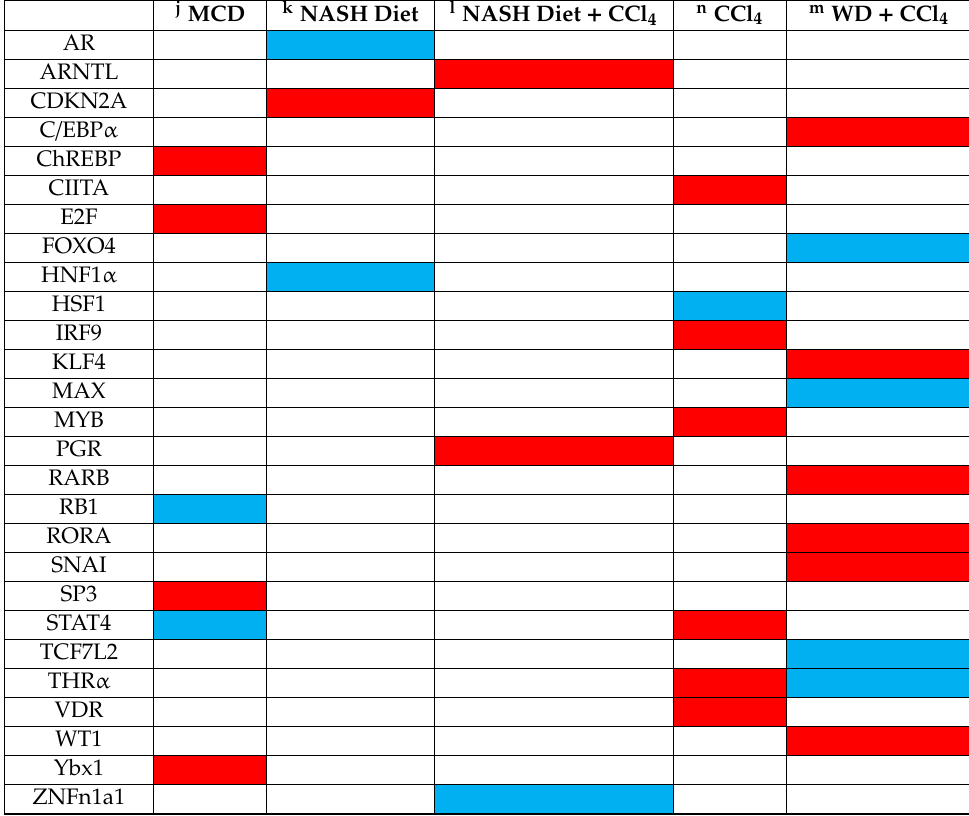
Table 4. IPA prediction of upstream mechanistic networks that are unique to each mouse model.